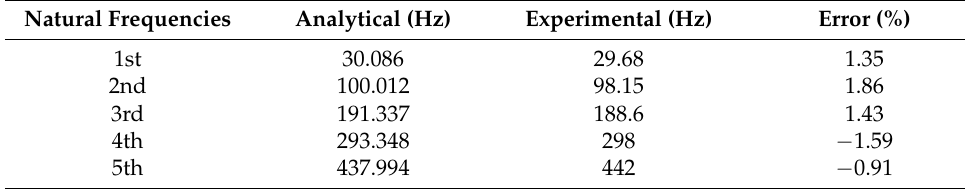
Table 4. The first five natural frequencies of the beam-end mass system. Natural